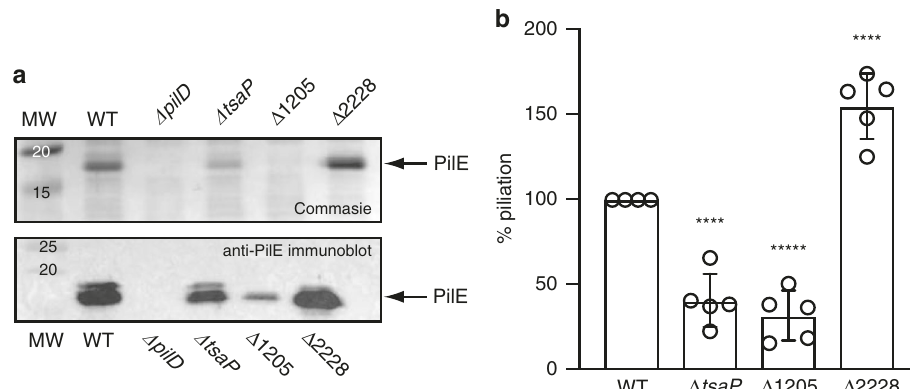
Fig. 7 Assaying piliation in the mutants in genes not previously associated with T4P biology in N. meningitidis . The WT strain and a non-piliated Δ pilD mutant were included as positive and negative controls, respectively. Δ tsaP , Δ tsaP mutant; Δ 1205, Δ NMV_1205 mutant; Δ 2228, Δ NMV_2228 mutant. a T4P puri fi ed using a shearing/precipitation method were separated by SDS-PAGE and either stained with Coomassie blue (upper panel) or analysed by immunoblotting using an antibody against the major pilin PilE (lower panel) 59 . Samples were prepared from equivalent numbers of cells and identical volumes were loaded in each lane. MW molecular weight marker lane, with values in kDa. Source data are provided as a Source Data fi le. b T4P were quanti fi ed by whole-cell ELISA using a monoclonal antibody speci fi c for the fi laments of strain 8013 58 . Equivalent numbers of cells, based on OD 600 readings, were applied to the wells of microtiter plates. Results are expressed in % piliation (ratio to WT) and are the average ± standard deviations from fi ve independent experiments. Source data are provided as a Source Data fi le. For statistical analysis, one-way ANOVA followed by Dunnett ’ s multiple comparison tests were performed (**** P <